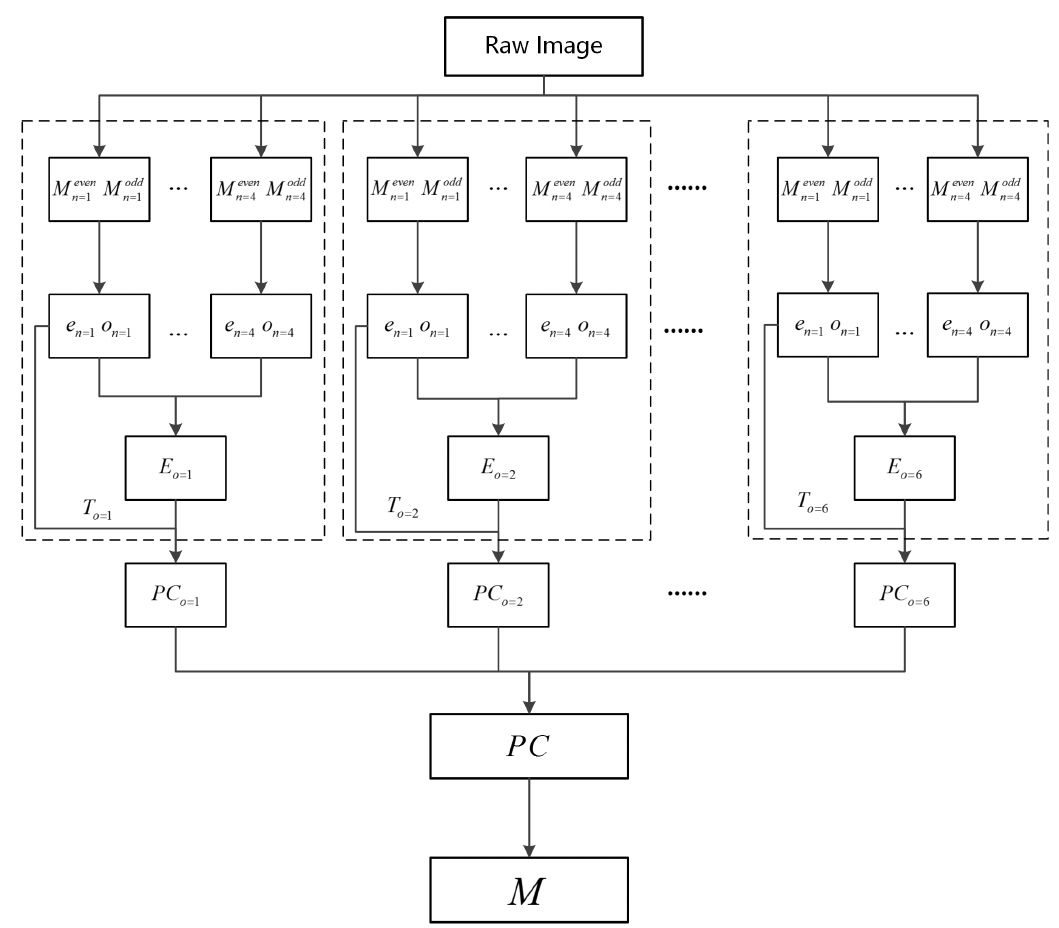
Figure 2. Flow chart of the Phase Congruency detector